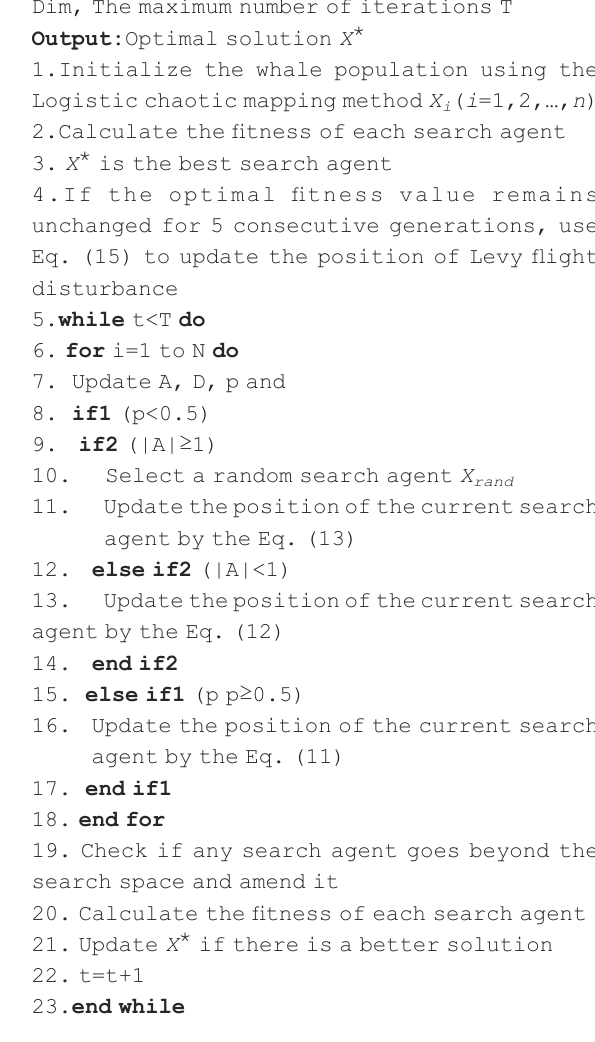
ALGORITHM 2. | IMPROVED WHALE OPTIMIZATION ALGORITHM